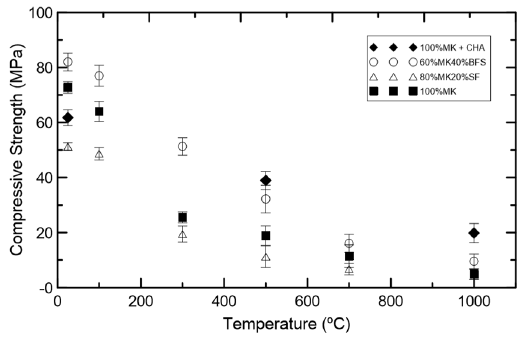
Figure 7. The effect of exposure to elevated temperatures on the compressive strength of the geopolymer matrices (error bars indicate standard deviation).